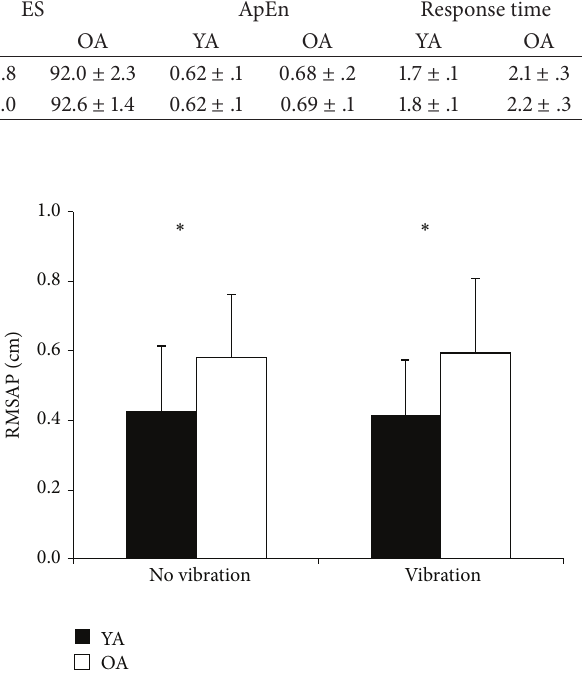
Figure 2: COPmax A means and SD of younger age group (YA) and older age group (OA) without vibration and with vibration. ∗∗ = 𝑝 < 0.01 .